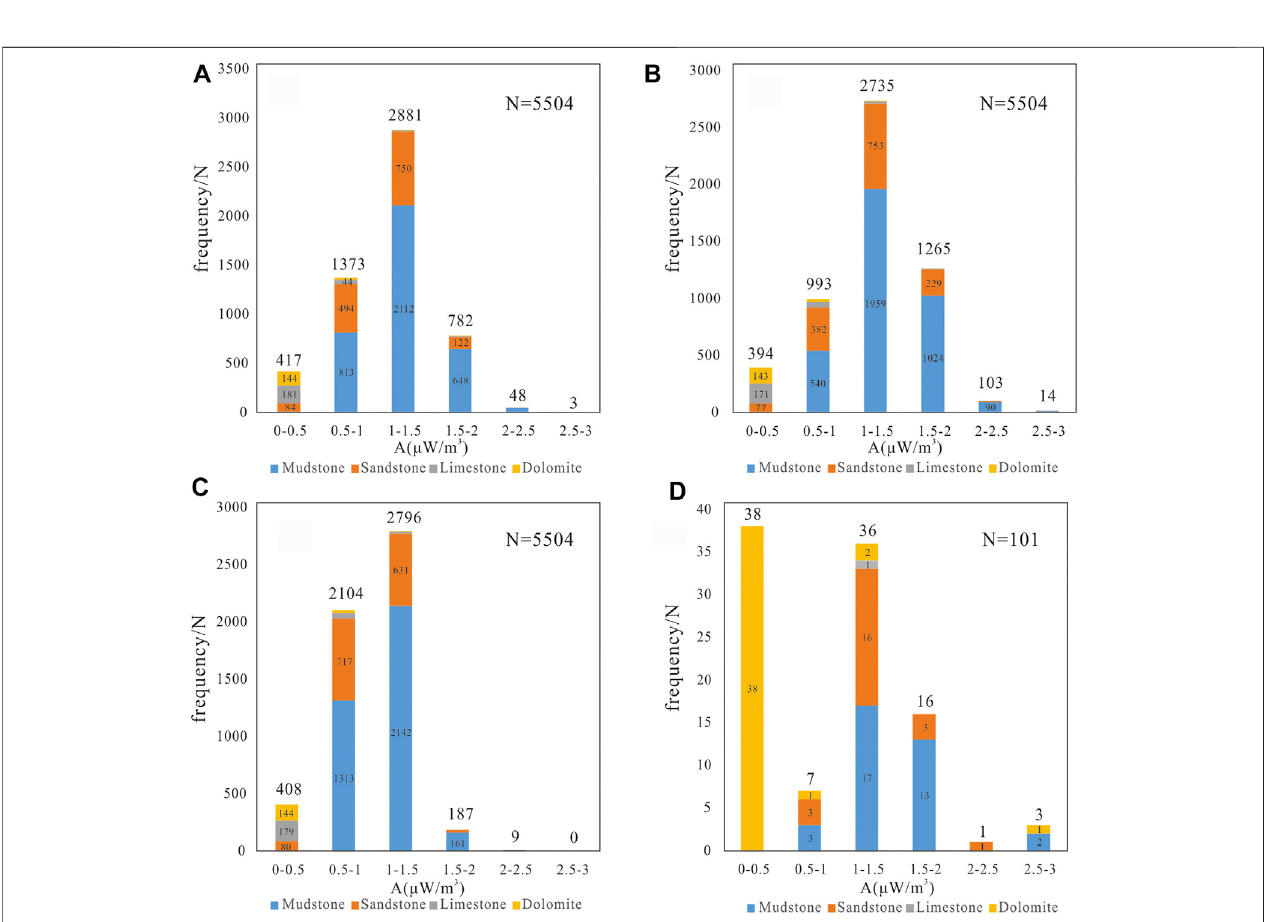
FIGURE3| StatisticfrequencyhistogramofsedimentarycalculatedheatproductionusingGR-AempiricalrelationshipsandmeasuredheatproductioninXiong ’ an new area. (A) is calculated heat production using empirical relationship by Rybach (1986); (B) is calculated heat production using empirical relationship by Bucker and Rybach (1996); (C) is calculated heat production using empirical relationship by Luo et al. (2008); (D) was measured heat production by Gong (2003) and Cui et al. (2019).